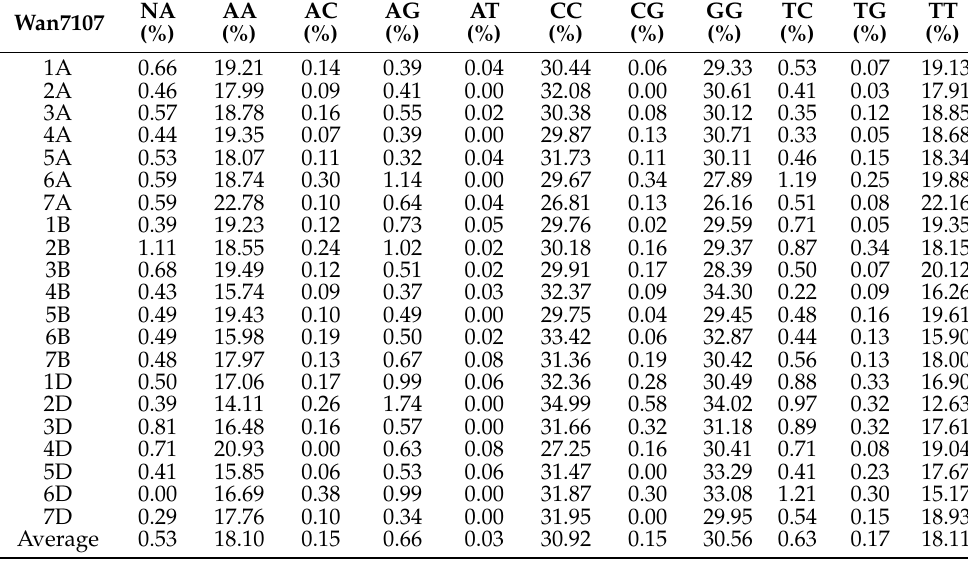
Table 1. Genotyping ratio on each chromosome in Wan7107.